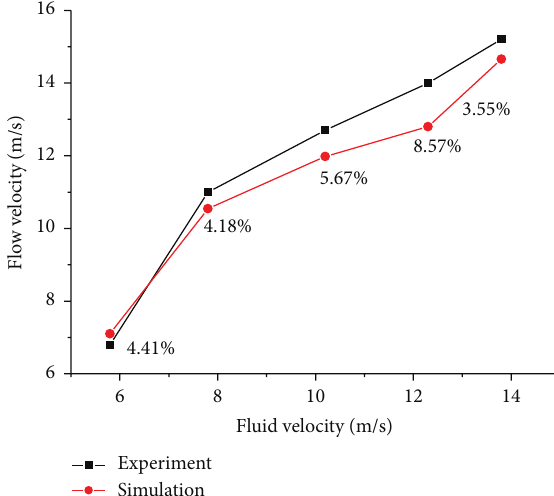
Figure10:Relativeerroroftheflowvelocitybetweensimulationand experiment in section.